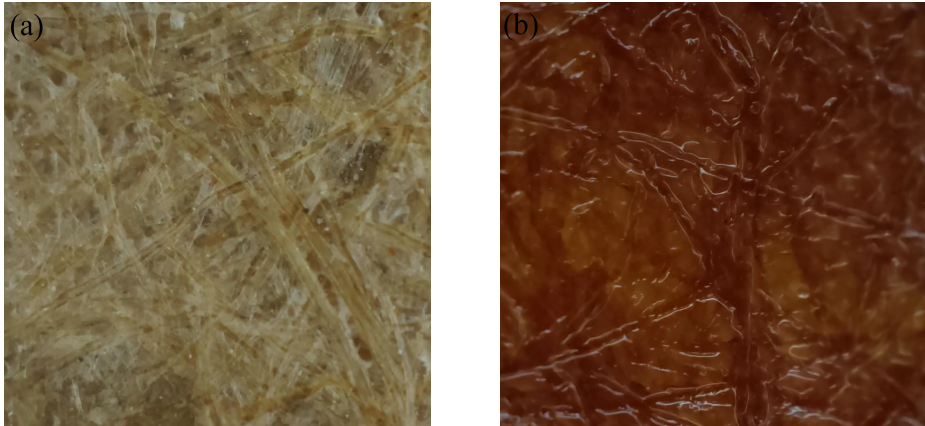
Figure 1. Surface of insulator paper observed by optical microscope: ( a ) non-oil-impregnated insulator paper; ( b ) oil-impregnated insulator paper.